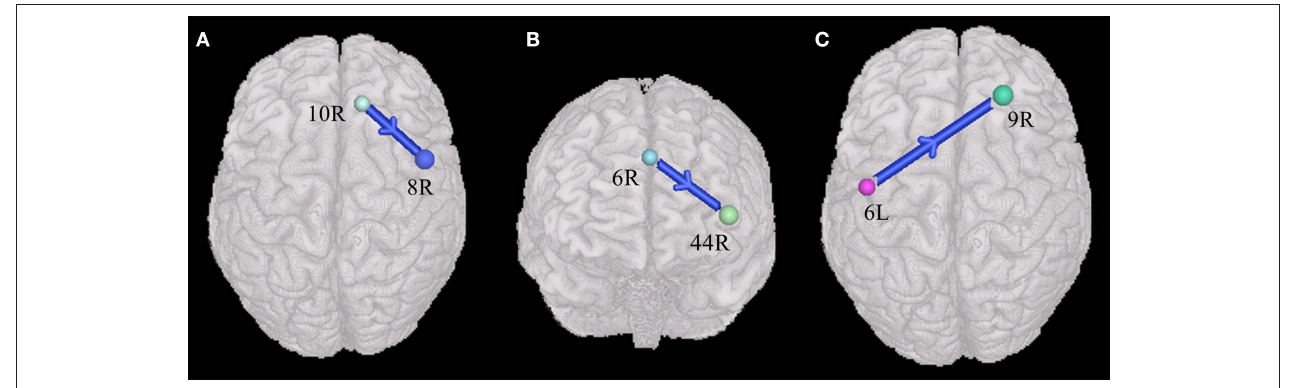
FIGURE 6 | Weakened synchronous entropy connectivity (BA 21L → BA 10L) ( p < 0.05, two-sided, PRT corrected; reproducible rate: 0.85; number of subjects: 70; PRT threshold: 1,000). The blue arrow denotes weakened interregional connectivity. Every colored sphere in the figure indicates the seed brain region of entropy connectivity, and the color of the sphere is randomly generated and has no special meaning. The number next to the sphere is the index of BA (see Table 2 for details). The direction of the arrow indicates the direction of directional